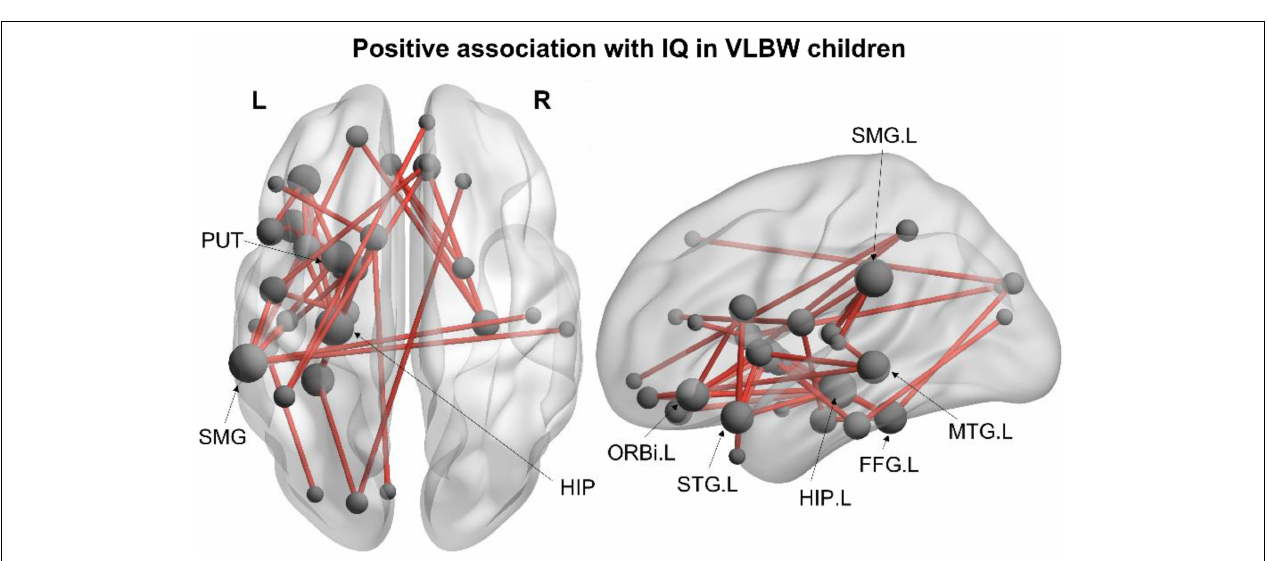
FIGURE 1 | Between-group network analysis. Increased resting-state functional connectivity in VLBW compared to FT children in the gamma (65–80 Hz) frequency band (42 edges, 29 nodes, p corr = 0.03). Node size is scaled by degree (i.e., the number of connections a node has).